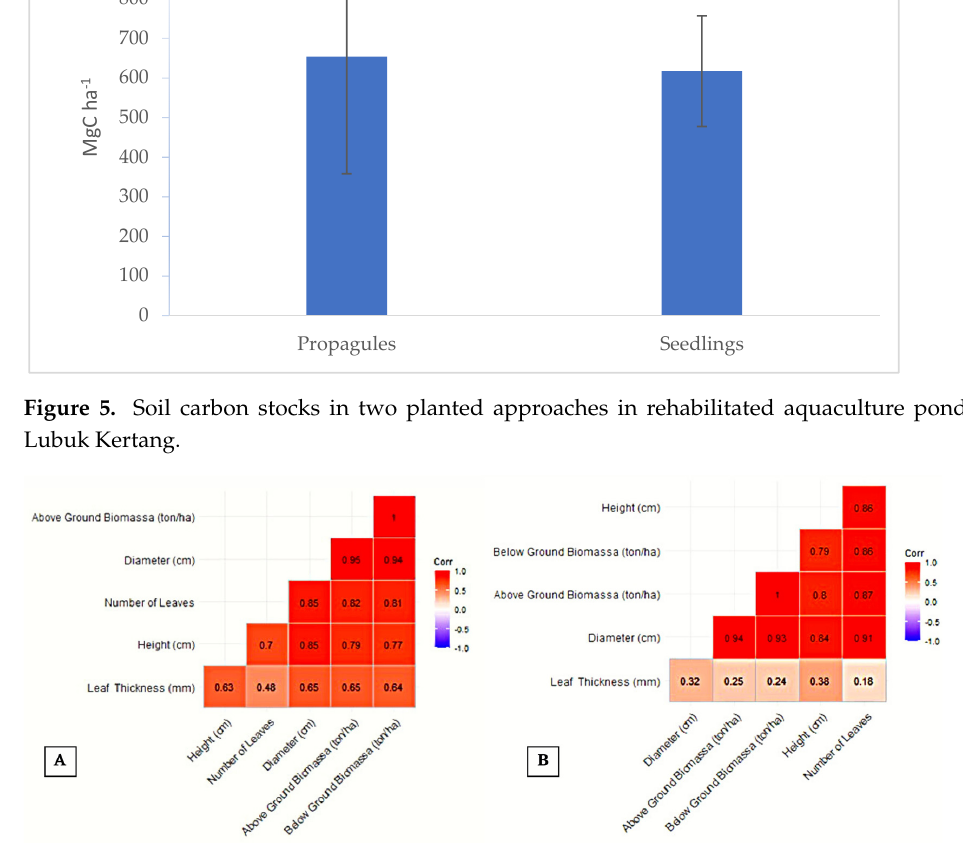
system carbon stocks (including biomass carbon pool) in the planted site using propagules were 558.07 MgC ha − 1 , while that in the planted site using seedlings were 518.64 MgC ha − 1 .